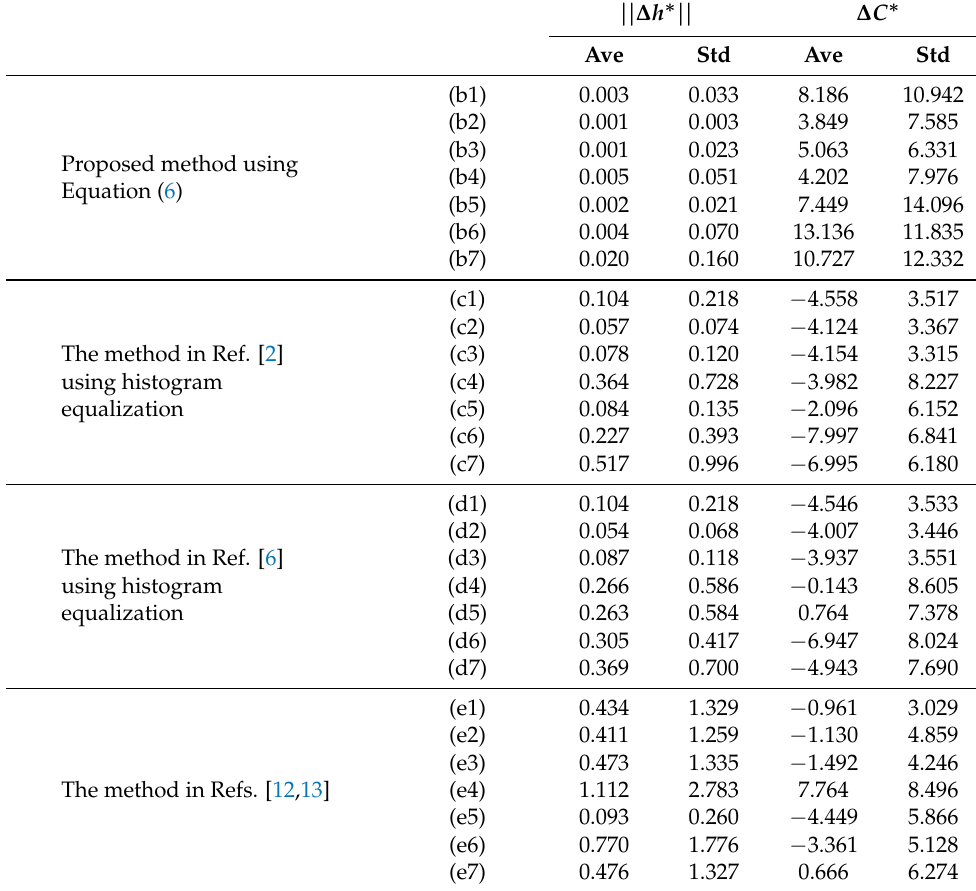
Table 1. Averages and standard deviations of || ∆ h ∗ || and ∆ C ∗ .